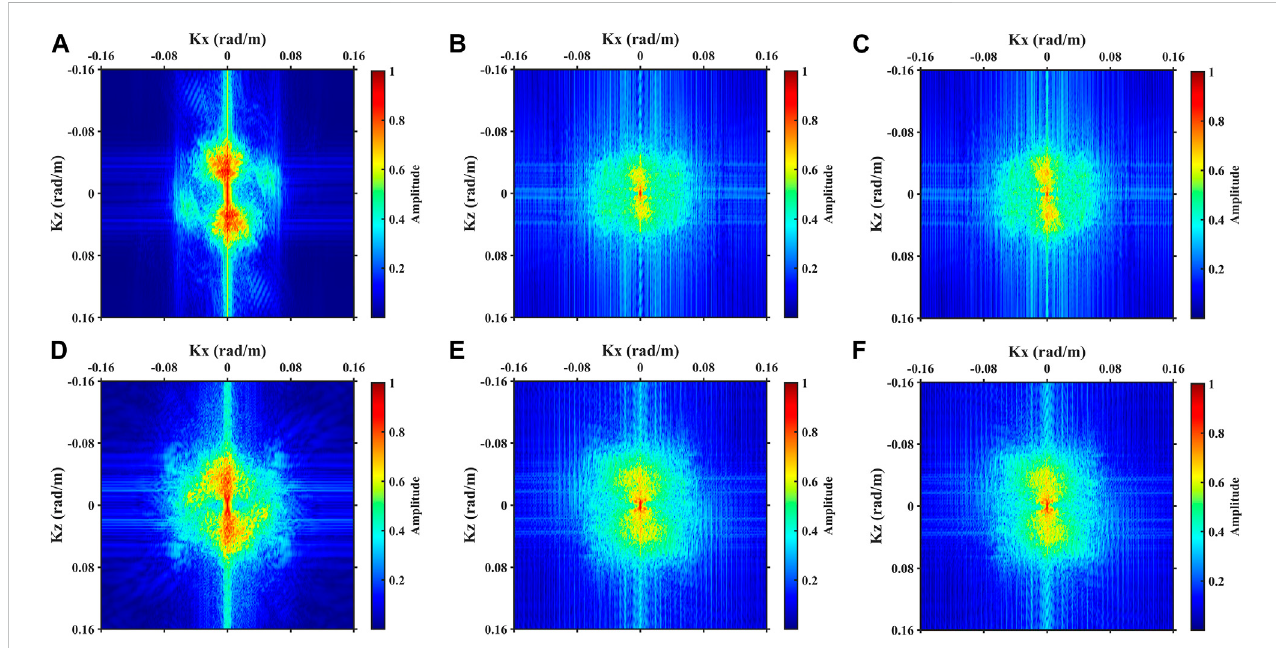
The spectrums of updating directions. (A – C) are the P-wave velocity updating direction of TS-FWI, OBS-FWI and J-AEFWI, respectively. (D – F) are the S-wave velocity updating direction of TS-FWI, OBS-FWI and J-AEFWI, respectively.